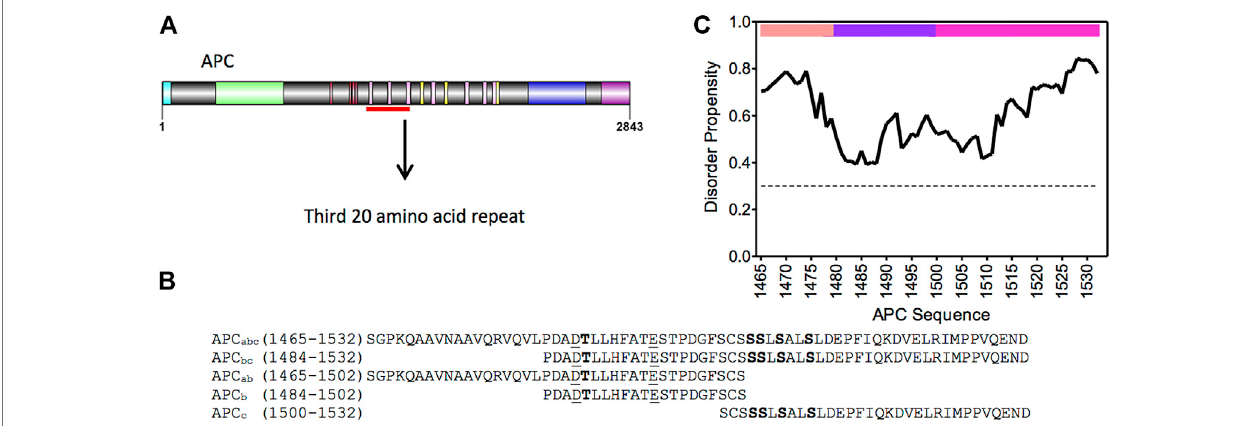
FIGURE 1 | APC and β -catenin. (A) Schematic of the domain structure of APC from N- to C-terminus: coiled-coil oligomerisation domain, turquoise; armadillo domain, light green; β -catenin- binding 15aa repeats, red; β -catenin-binding 20aa repeats, pink; axin-binding SAMP repeats, yellow; microtubule-binding basic region, blue;andEB1-bindingdomain,purple.Themutationalclusterregionisunderlinedinred. (B) Sequenceofthethird20aarepeatconstructofAPC,andfragmentsthereof, usedinthisstudy.Phosphorylatedresiduesareinbold,andlysine-interactingresiduesareunderlined. (C) Predictionofdisorderpropensityofthethird20aarepeat (R3) of APC using the fl DPnn program. Amino acids with values above the dotted line are predicted to be disordered and those below ordered (Hu et al., 2021). The coloured bars at the top ofthe graphrepresentthe three subdomains ofAPC R3: theN-terminal α -helicaldomain isin peach (APC a ),the lysine-bindingdomain inpurple (APC b ), and the phosphorylation domain in pink (APC c ).